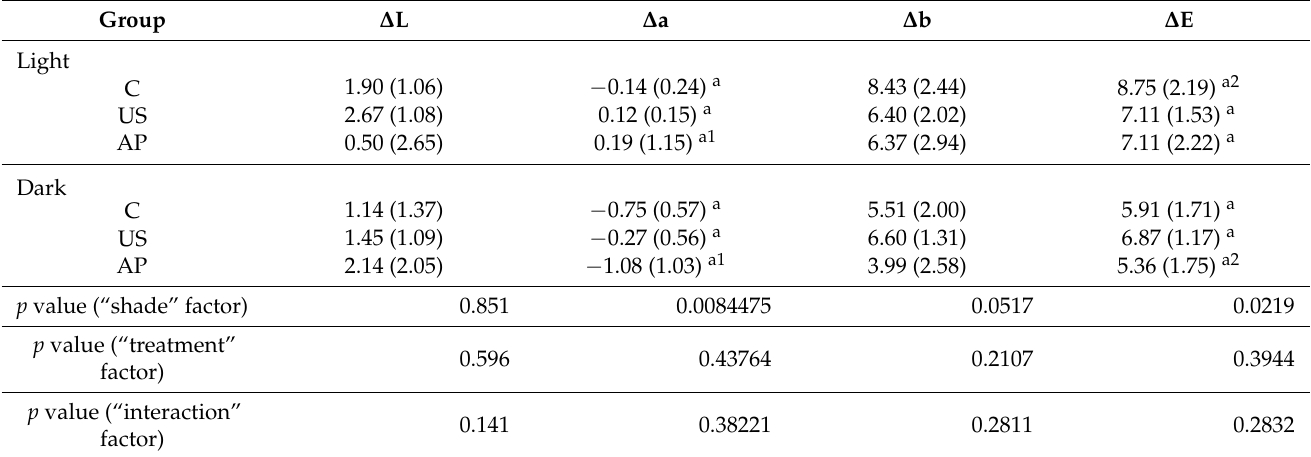
Table 4. Mean CIELab color difference values (standard deviation) of the tested specimens at baseline and after immersion in coffee